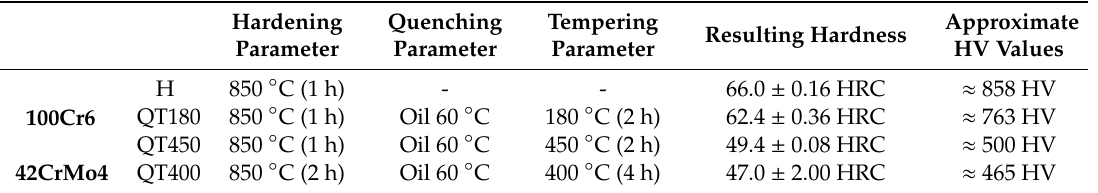
Table 7. Material states from [15] and [16] used for comparison (calculation of HV values according to [23]).